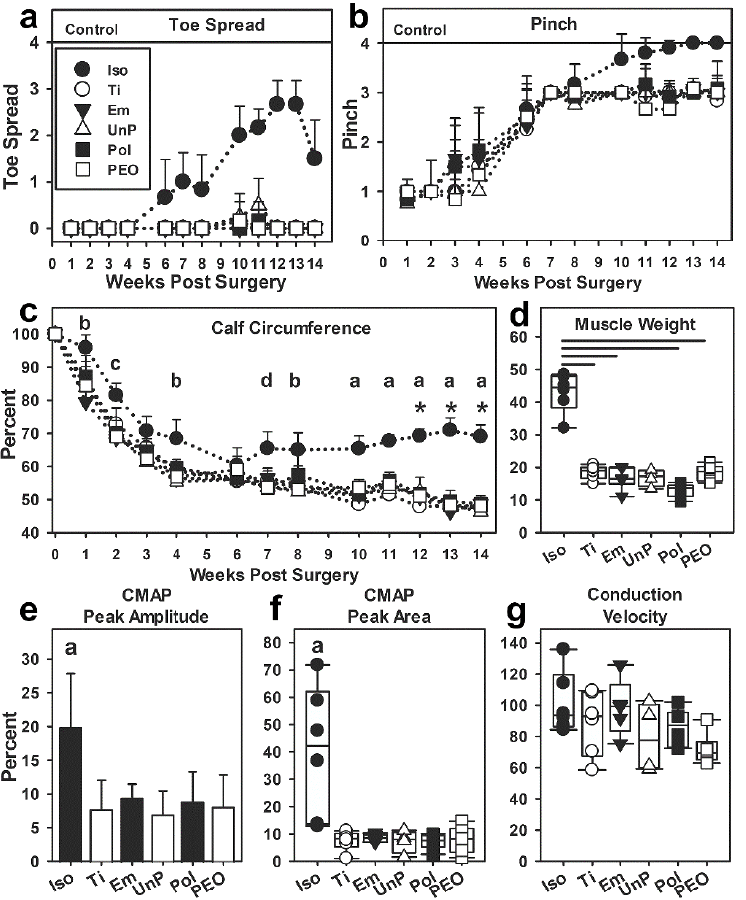
Figure 7. Functional measures. ( a ) Reflex toe spread in live animals. ( b ) Pinch test in live animals. ( c ) Muscle atrophy in live animals analyzed by measuring calf circumference (injured normalized to control leg as a percent, week 0 values are a place keeper, not used in statistics). Statistics indicated by letters are as follows: a = Iso > all groups; b = Iso > all but Pol; c = Iso > all but Ti; d = Iso > all but Em. The ( * ) indicates Iso > its 6 WPS value. ( d ) After euthanasia at 14 WPS, dissected calf muscles were weighed. Bars indicate significant differences by SAS. ( e – g ) Electrophysiological measurements of nerve integrity were recorded immediately before euthanasia (injured/control leg as a percent). ( e ) Compound muscle action potential (CMAP) peak amplitude. ( f ) CMAP peak area. ( g ) Conduction velocity. Symbols are in Toe Spread legend.